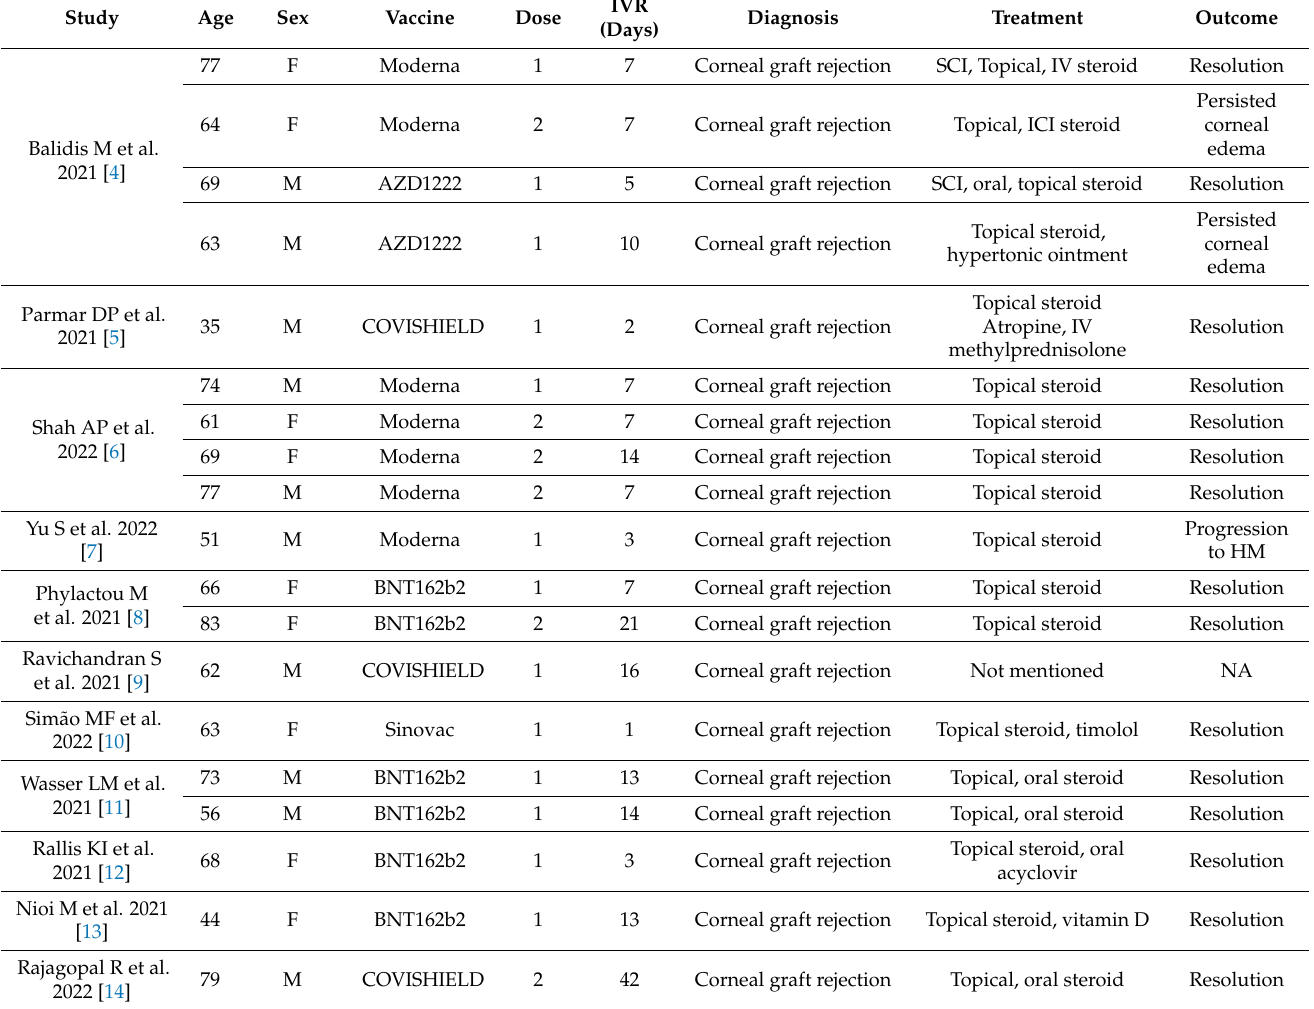
Table 1. Review of literatures about corneal complications after COVID-19